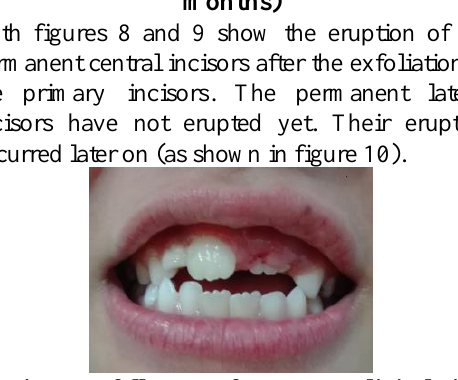
Figure 8: follow up after 2 years clinical view showing eruption of both central incisors (note; the age of the child at this time was 6 years and